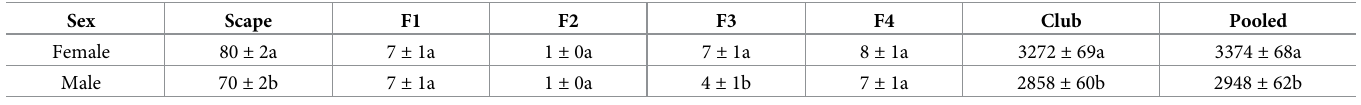
Table 3. The number of sensilla in antennal segments of female and male E . parallelus (n = 8).